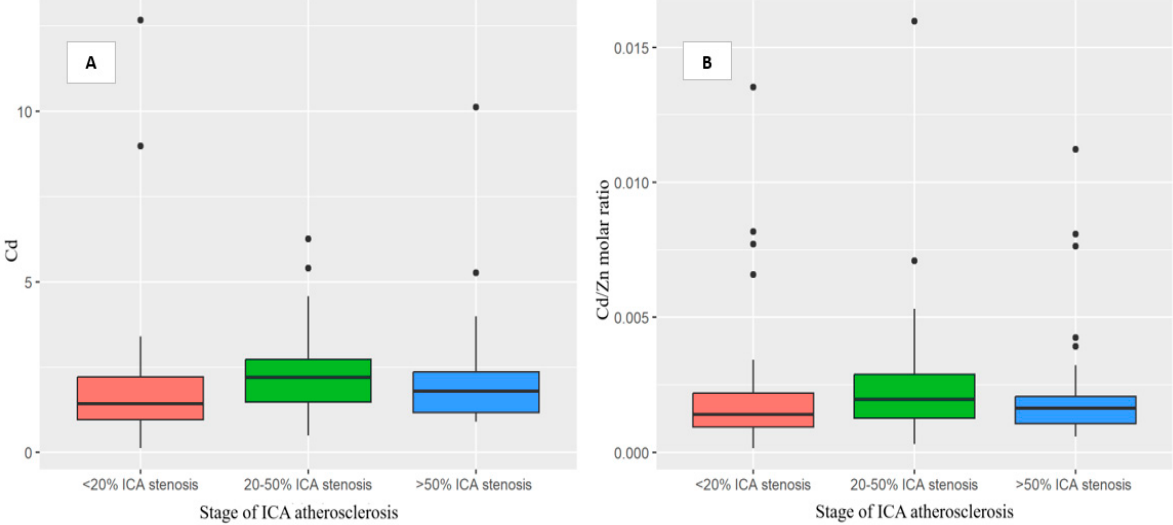
Figure 2. Box plot showing the findings regarding the Cd ( A ) and Cd/Zn ( B ) molar-ratio levels in acute-ischemic-stroke patients in relation to the stage of ICA atherosclerosis—B-mode ultrasound imaging using a standardized protocol or neck CT angiography. The patients with more advanced stages of ICA atherosclerosis had higher concentrations of the Cd and Cd/Zn molar-ratio levels, particularly those with 20–50% ICA stenosis. Abbreviations: Lead, Pb. Cadmium, Cd. Copper, Cu. Selenium, Se. Zinc, Zn. Internal carotid artery, ICA. Computed tomography, CT. Acute ischemic